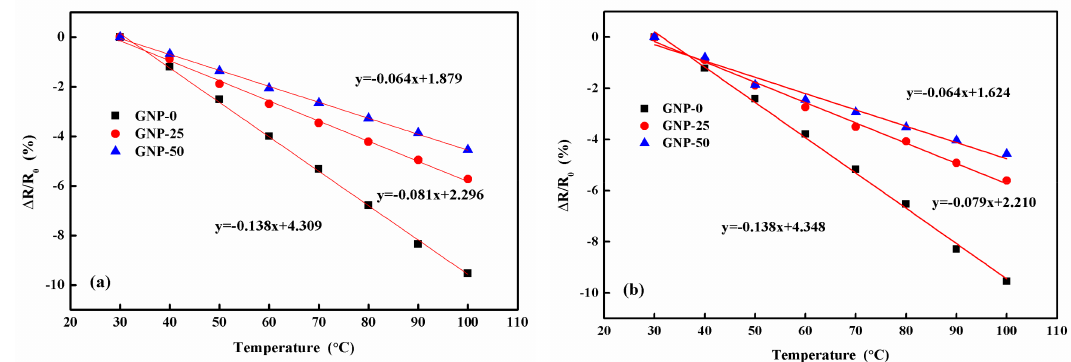
Figure 11. Normalized relative resistance change of the hybrid films varied with temperature. ( a ) Atomsphere environment; ( b ) Vacuum oven.